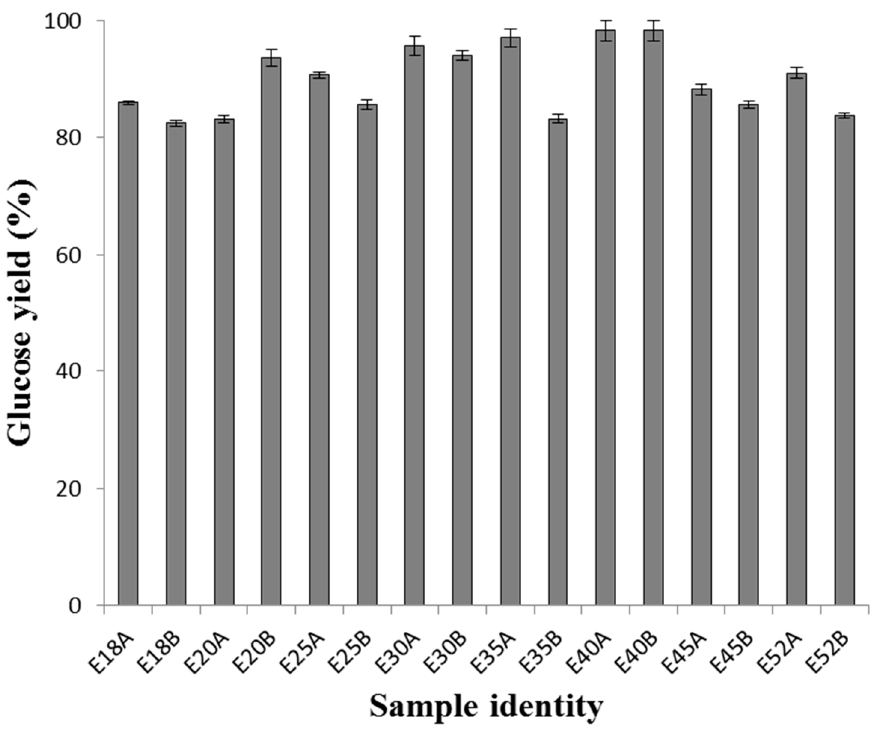
Figure 2. Glucose yield of dilute acid-pretreated sorghum stalks.